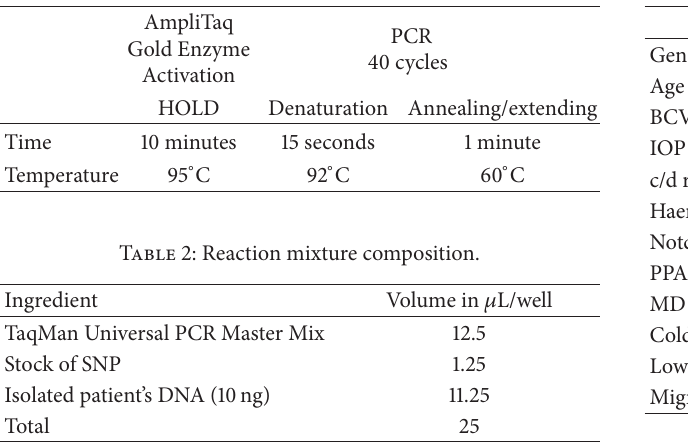
Table 1: Standard amplification report.